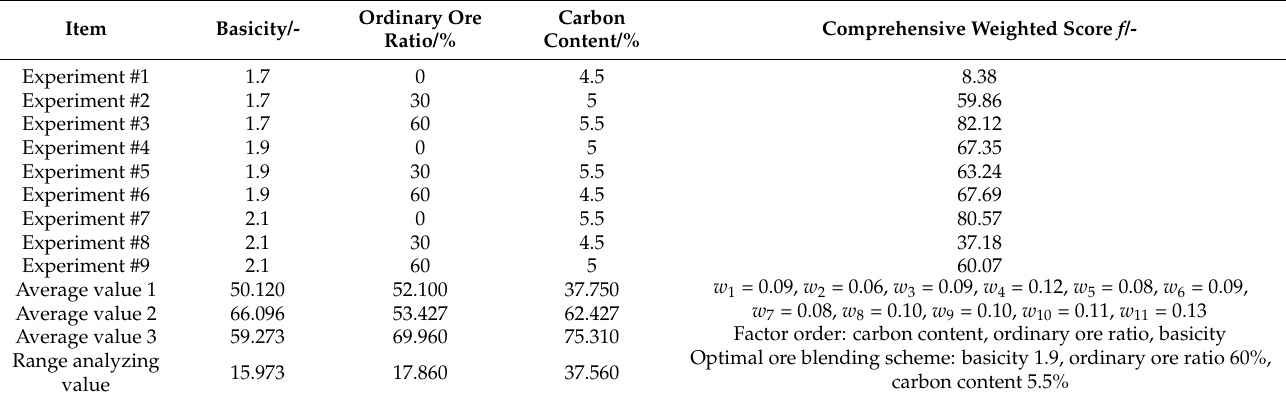
Table 16. Comprehensive weighted scoring